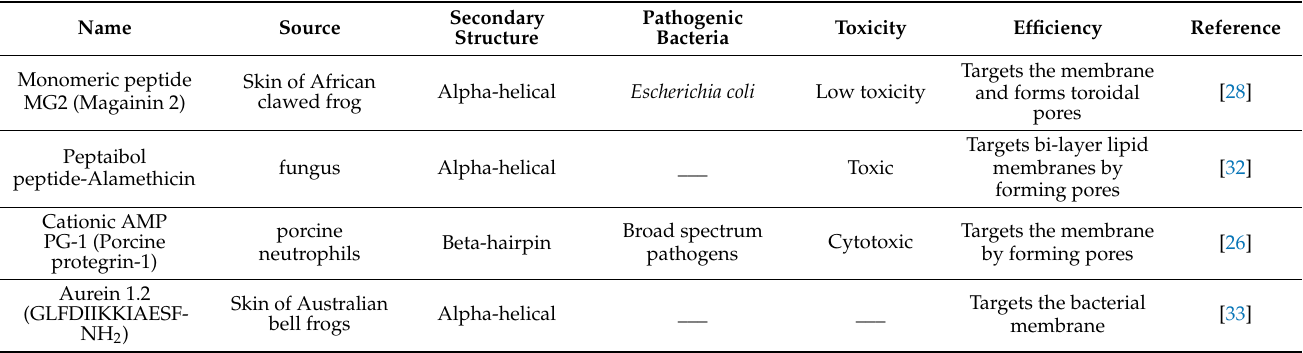
Table 1. The source, safety, structure, and action of